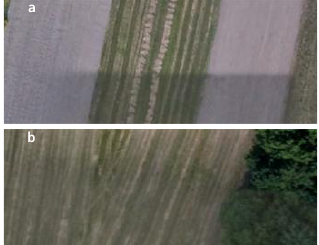
Figure 9. Example radiometric imperfections of automatic mosaicking